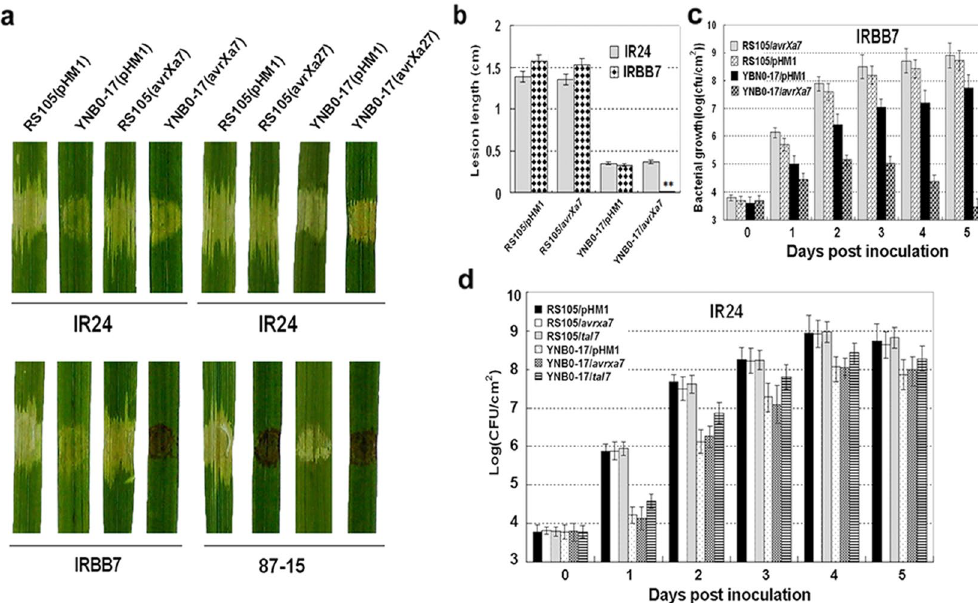
Figure 1. Heterologous expression of avrXa7 and avrXa27 in X . oryzae pv. oryzicola ( Xoc ) strains YNB0- 17 and RS105 and inoculation to rice cv. IR24 (susceptible) and IRBB7 (contains R gene Xa7 ) and 87-15 (contains R gene Xa27 ). ( a ) YNB0-17 and RS105 containing avrXa7 and avrXa27 were infiltrated into seedlings of IRBB7 ( Xa7 ) and 87-15 ( Xa27 ) with needleless syringes. The susceptible rice cultivar IR24 and strains containing the empty vector pHM1 were used as controls. Leaves were scored for water-soaked symptoms or HRs within the infiltrated area 2 dpi and were designated as susceptible or resistant (showing an HR). Leaves were photographed 3 dpi. ( b ) Strains YNB0-17 and RS105 carrying avrXa7 were inoculated to adult rice plants of IRBB7 ( Xa7 ) and susceptible line IR24. Lesion lengths were recorded 14 dpi. The vertical columns and intersecting bars represent the mean lesion length and SD from five replicate plants. The asterisks in each horizontal data column indicate significant differences at P = 0.01 using the Student’s t test. ( c ) Bacterial growth in rice IRBB7 inoculated with Xoc YNB0-17 and RS105 containing avrXa7 or the empty vector control (pHM1). ( d ) Bacterial growth of Xoc YNB0-17 and RS105 containing avrXa7 , tal7 or pHM1 in the BLS susceptible rice line IR24. Leaf discs (0.8 cm diameter) were excised from the inoculated areas, homogenized in sterile water, diluted and plated on to NA. Data points represent the mean ± SD from three replicates. All experiments were repeated three times, and similar results were